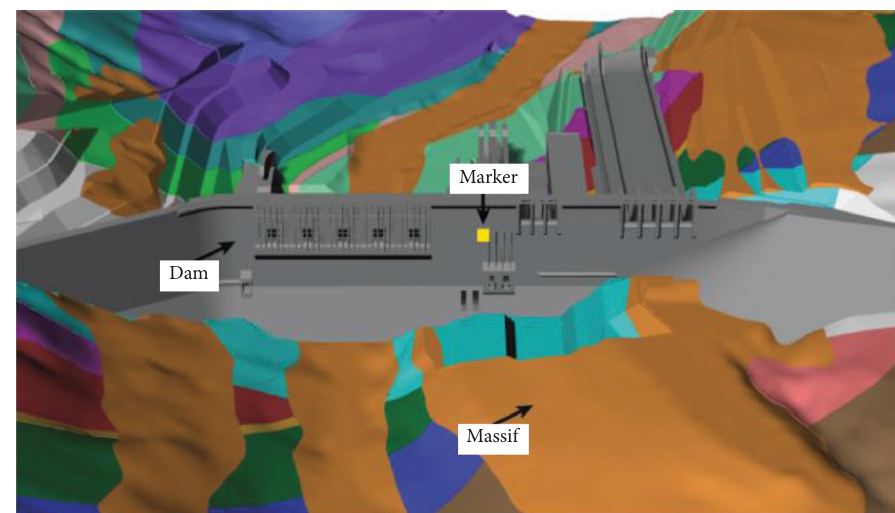
Figure 3: Schematic map of marker location on dam upstream side surface.